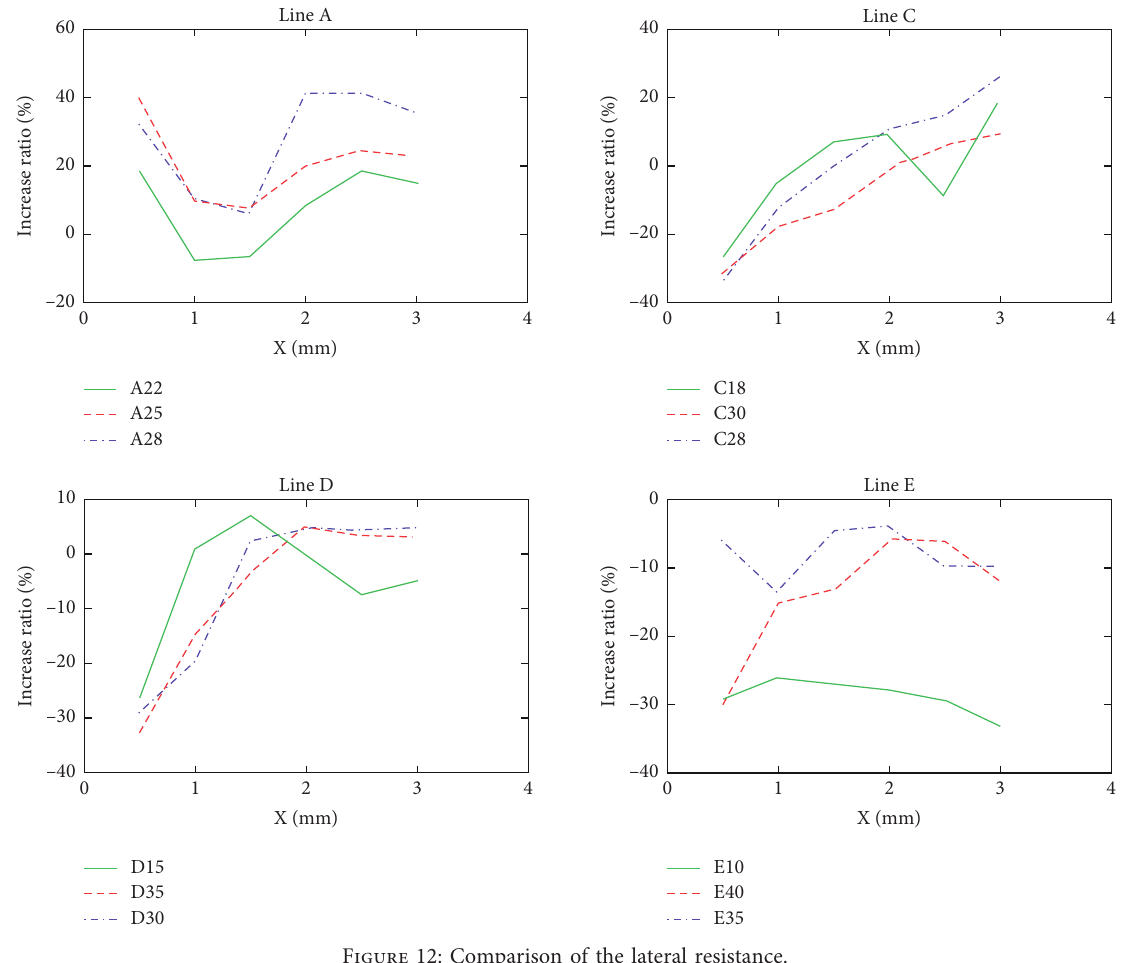
Figure 12: Comparison of the lateral resistance.